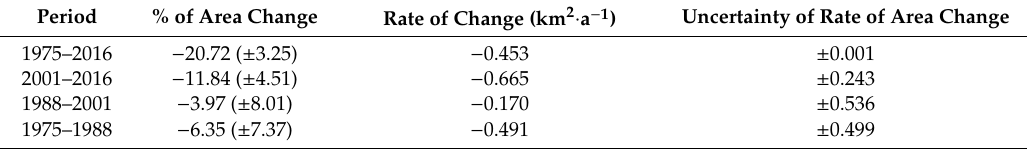
Figure 12. The bar graphs represent glacier area dynamics: 1975–2016, 1975–1988, 1988–2001, 2001–2016 ( a ) percentage of total glacier area changes ( b ) Rate of total glacier area recession ( c ) Percentage of glacier area recession, and rate of glacier area recession according to the type of glaciers. Table 4. Nature of glacier area change during the study period